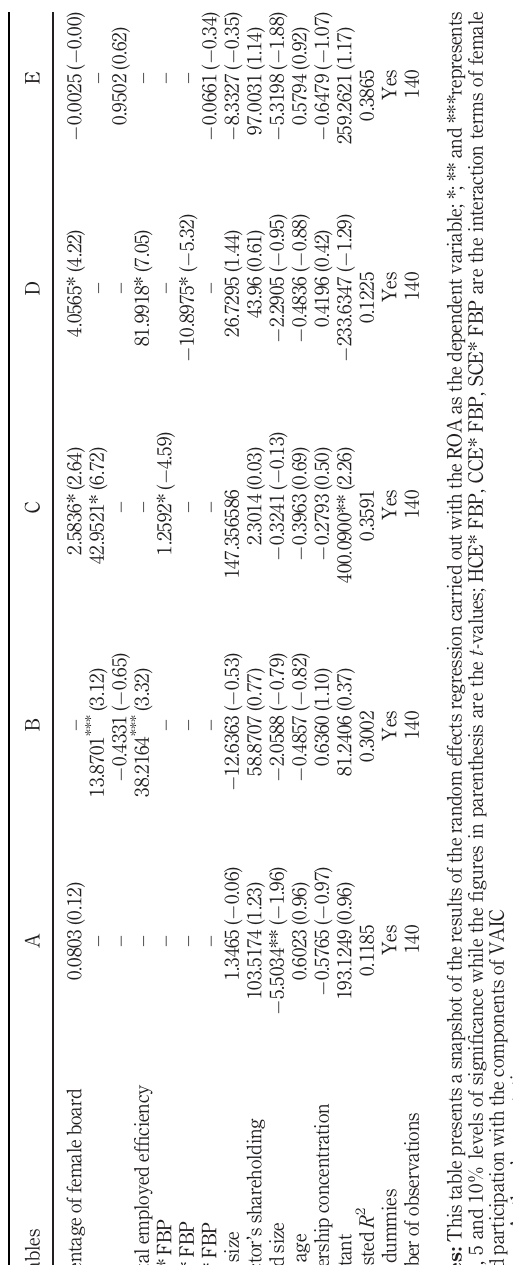
Table III. Empirical results (dep. variable: